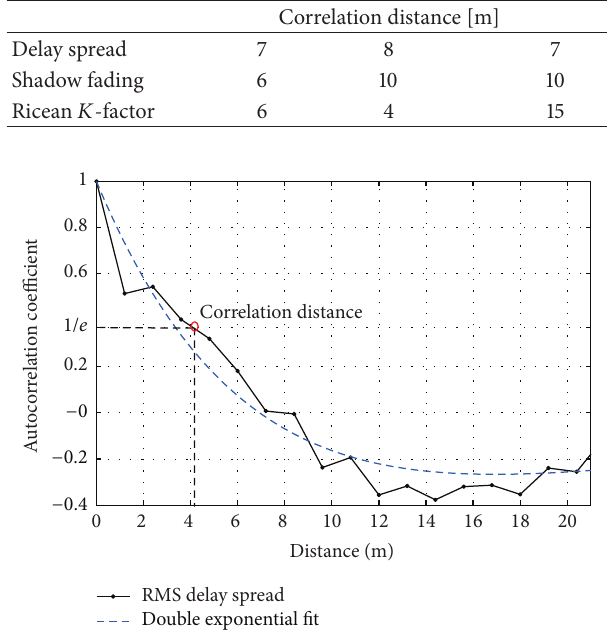
Figure 14: Empirical spatial autocorrelation function of RMS delay spread with a double exponential